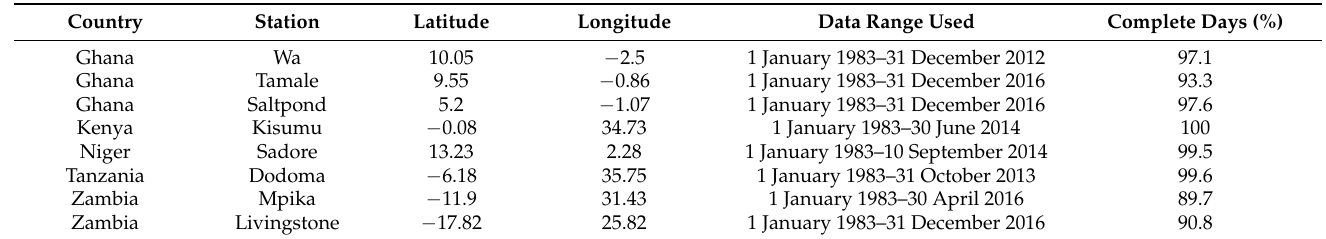
Table 1. Details of the eight station sites and properties of the station temperature data records.